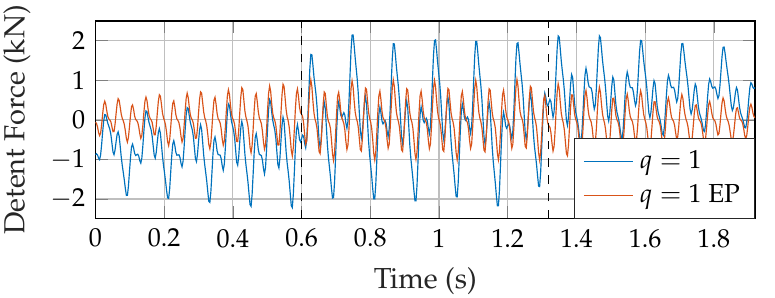
Figure 7. Phase voltages of the buried topology for q = 1 and q = 6 for 50 % active stator area. Full active stator area is from t = 0.6 s to t = 1.32 s, indicated by the dashed vertical lines. The different phases are indicated by different colors.